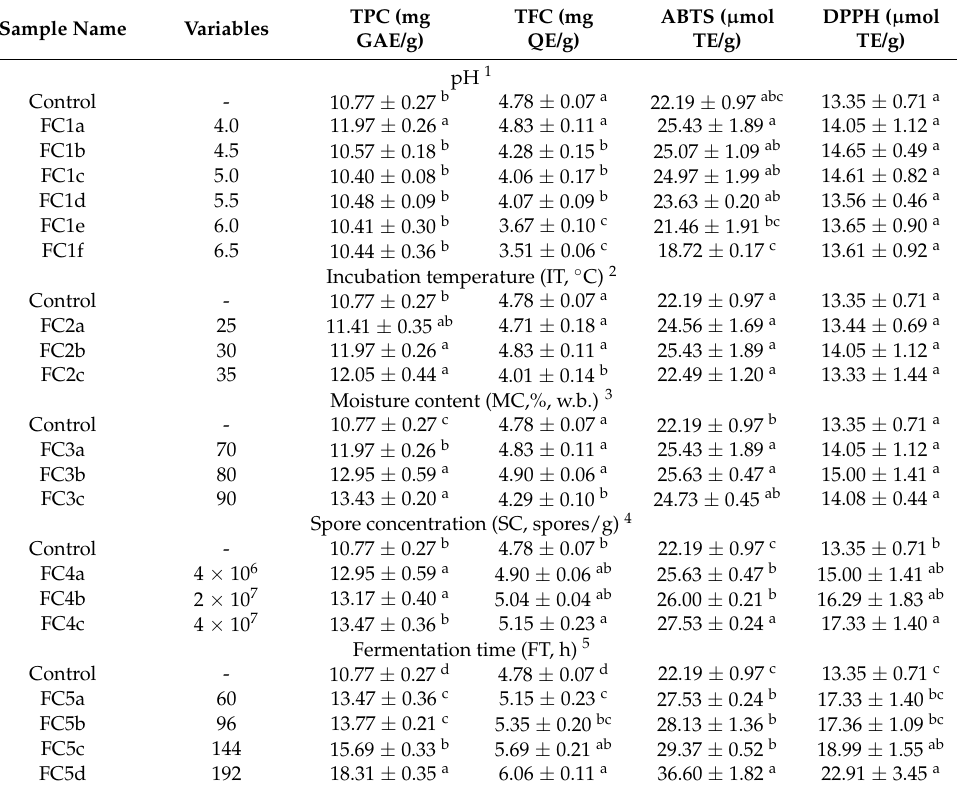
Table 1. Effects of solid-state fermentation conditions on the TPC, TFC, and ABTS and DPPH scavenging capacity of Citrus reticulata